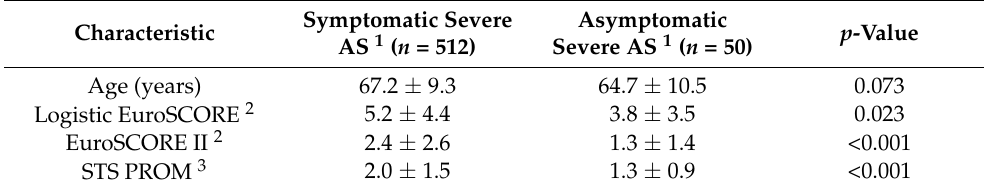
Table 9. Baseline